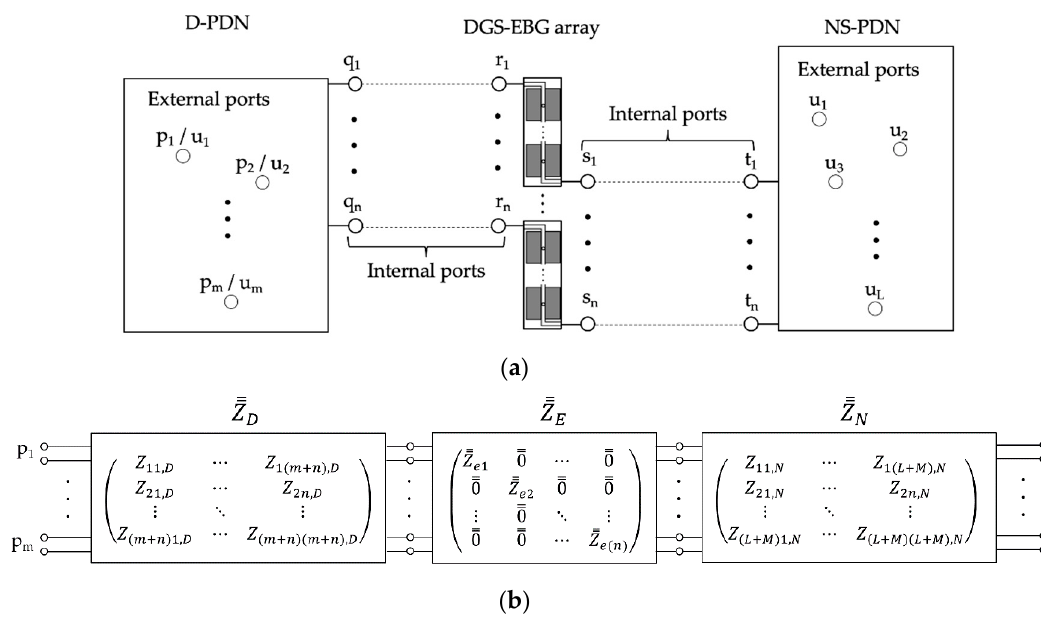
Figure 10. ( a ) Domain decomposition method (DDM) interconnection diagram; ( b ) impedance diagram for extraction of the Z-parameter of the original